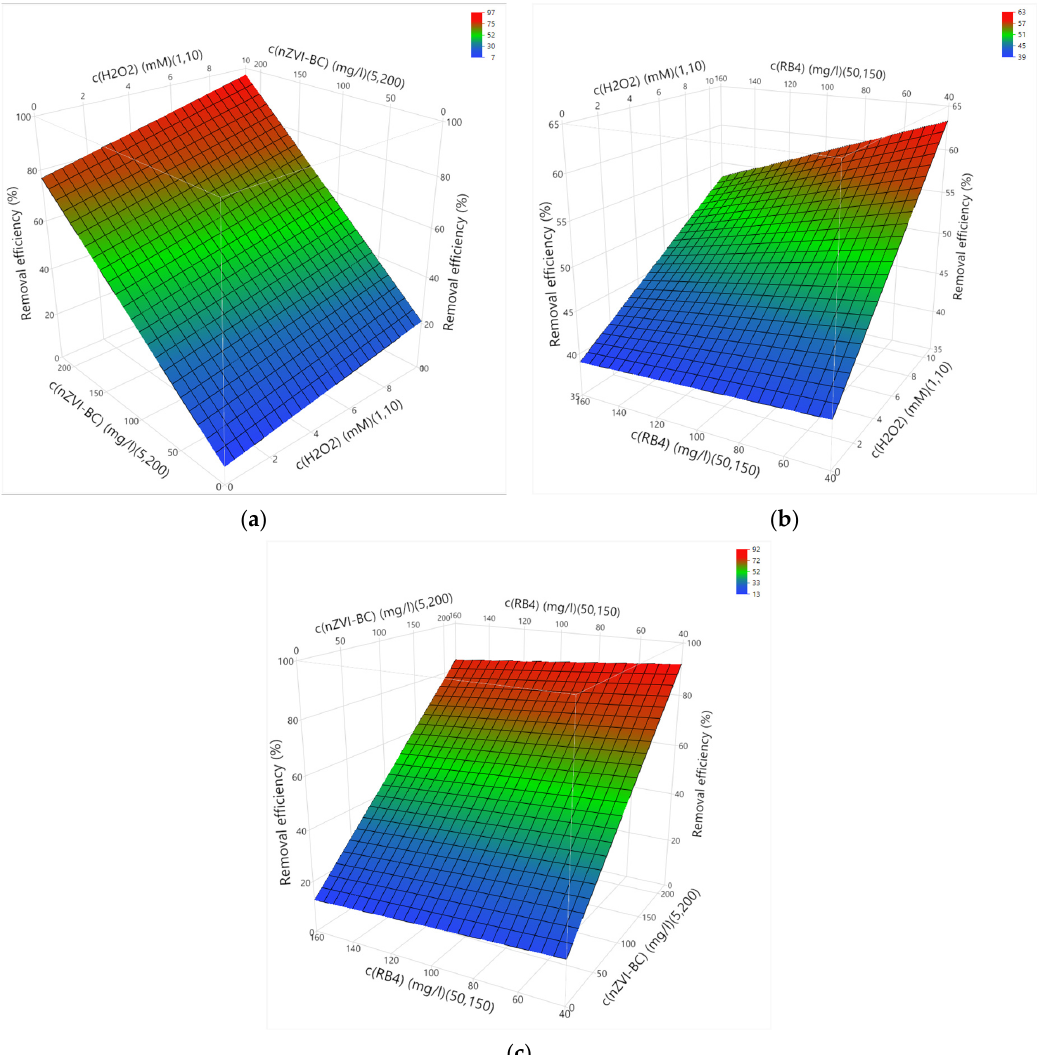
Figure 5. 3D graphics of the response surface of statistically significant interactions: ( a ) H 2 O 2 concentration and catalyst concentration; ( b ) H 2 O 2 concentration and dye concentration; ( c ) dye concentration and catalyst